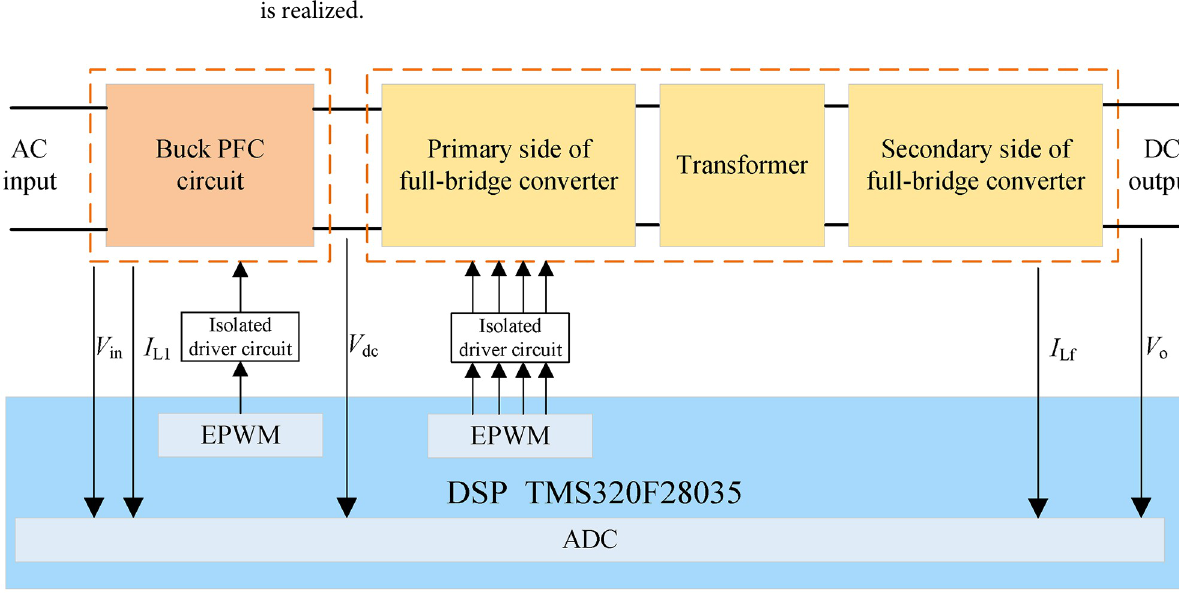
Fig 14. Software and hardware control flow